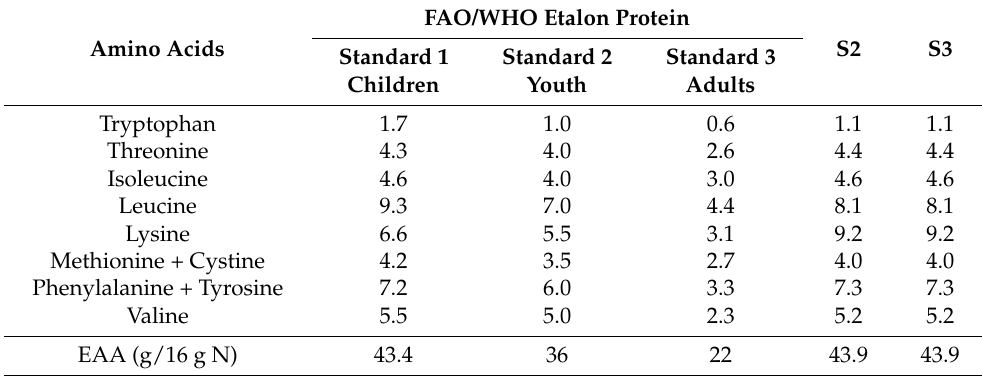
Table 9. Amino acids content (g/100 g protein) of the etalon protein and of the fillets sampled from Polyodon spathula sturgeons, aged two and three summers.